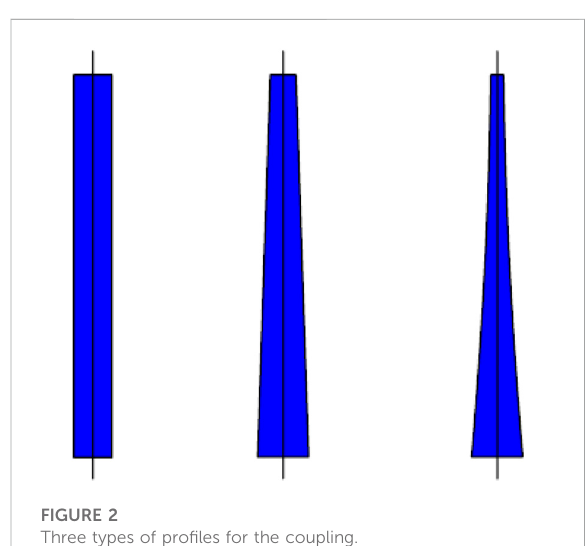
FIGURE 2 Three types of pro fi les for the